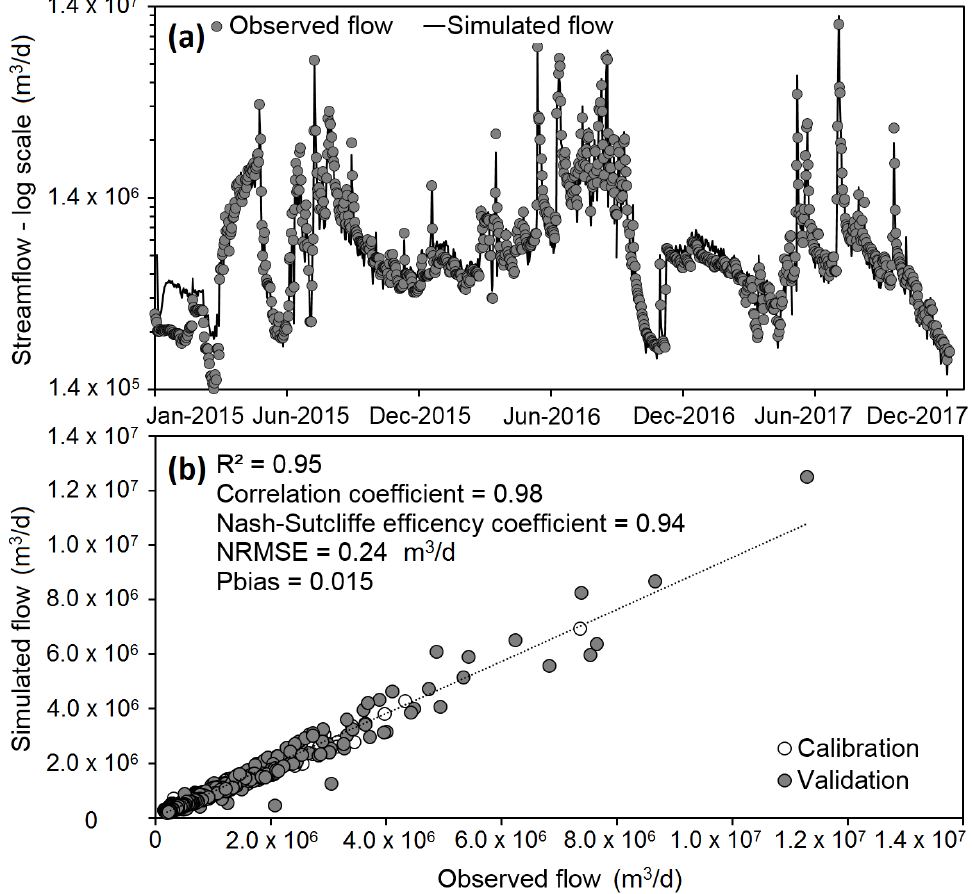
Figure 9. The comparison of the observed and simulated streamflow at Xing She Da Qiao station in the PPGB: ( a ) the variations of stream discharge rates in logarithmic scale, and ( b ) the scatterplot of simulated and observed stream discharge rates and the associated performance statistics for the model.